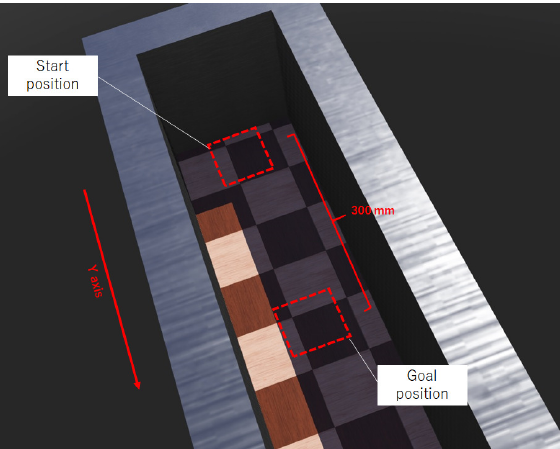
Figure 7. Virtual environment in Webots. In this figure, the distance between the start and goal position is 300 mm. The agent has learned the motion of the legs to begin moving towards the goal.